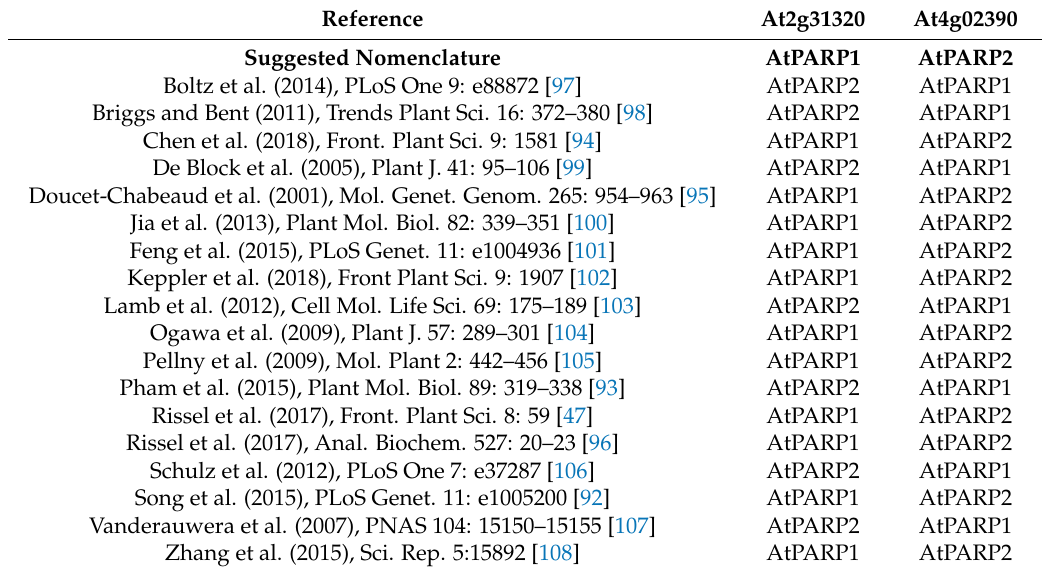
Table 1. Previously used and suggested nomenclature for AtPARP1 and AtPARP2 of Arabidopsis thaliana